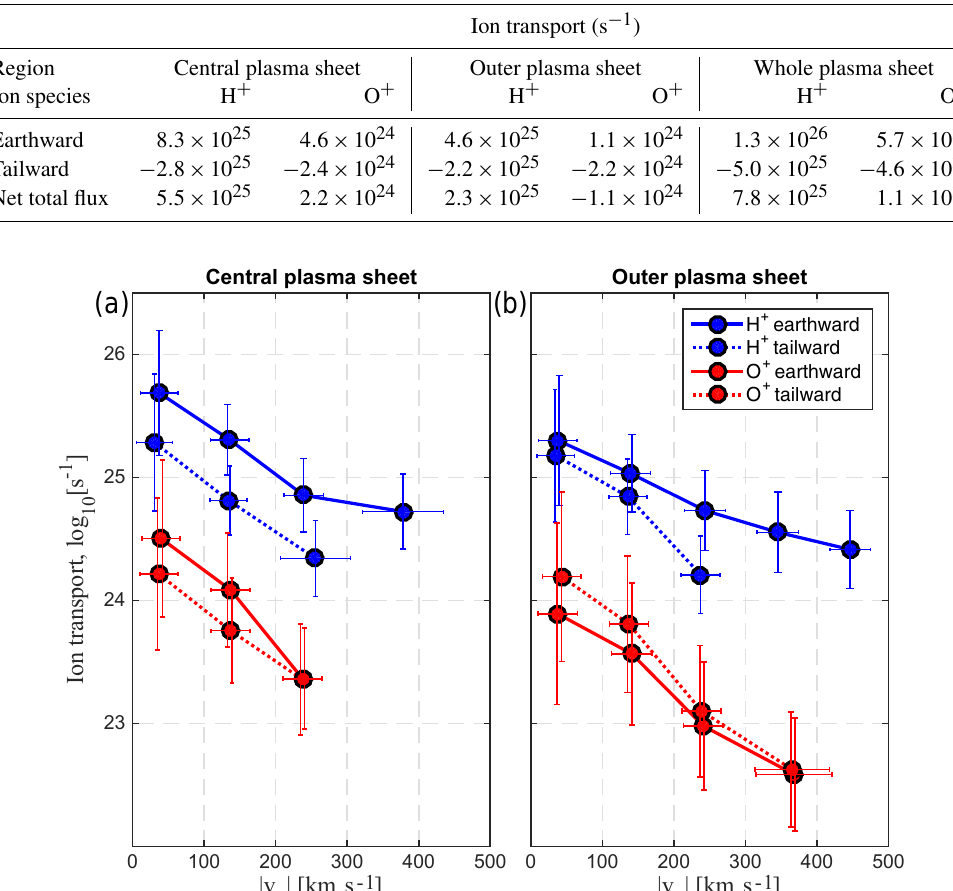
Figure 4. The estimated H + (blue) and O + (red) ion transport in the near-Earth plasma sheet, shown for earthward (solid line) and tailward (dotted line) flows separately, obtained for different v x intervals. The intervals are preliminarily chosen to have a width of 100kms − 1 but have been extended to 200kms − 1 a few times in order to include at least 10000 data points. The total fluxes are plotted against the average v x of the corresponding intervals, and the horizontal bars are the corresponding v x standard deviations. The vertical bars reflect the standard deviations of the local fluxes used in each corresponding total transport